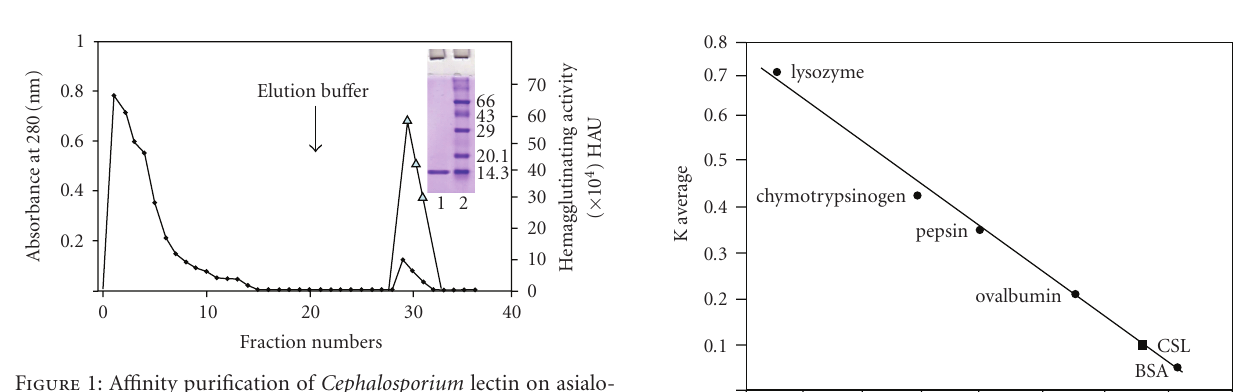
Figure 1: A ffi nity purification of Cephalosporium lectin on asialo- fetuin-Sepharose 4B column. Crude extract was passed through a ffi nity column, equilibrated in PBS, and the bound lectin was eluted with elution bu ff er. Fractions of 3.0 ml were collected at a flow rate of 15 ml/hr. Absorbance at 280 nm, Hemagglutinating activity. Inset- SDS-PAGE of a ffi nity purified CSL in 15% gel. The purified lectin (30 μ g) is indicated in lane 1 and lane 2 contains standard molecular weight markers. The gel was stained with Coomassie brilliant blue.